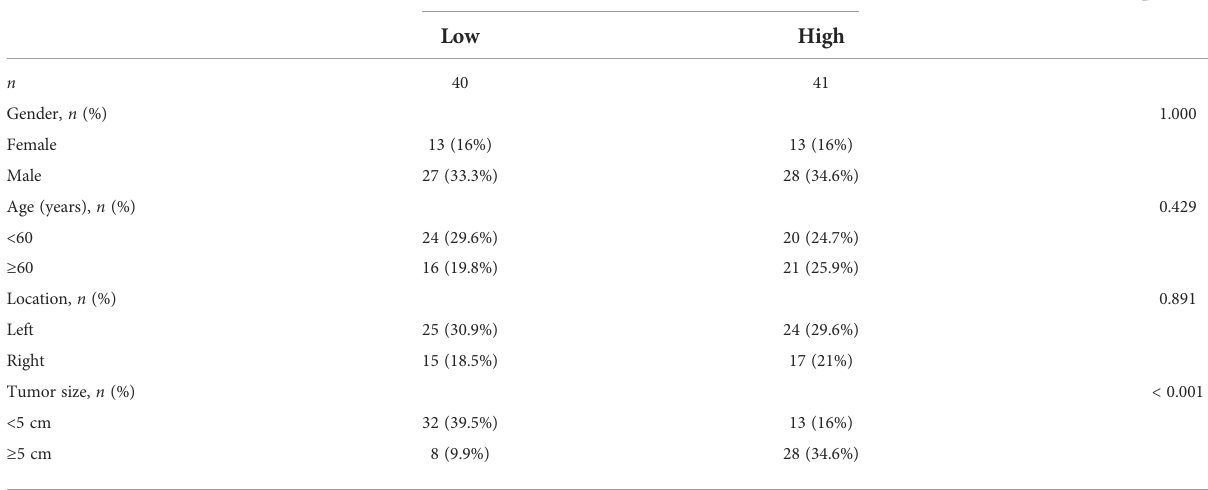
TABLE 2 Baseline characteristics of ccRCC patients in our